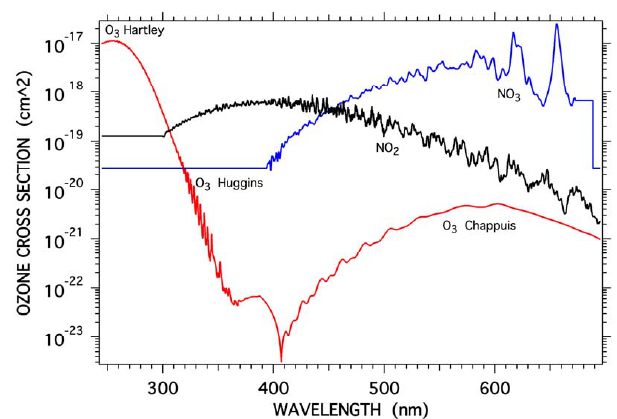
Fig. 2. Cross-sections of ozone (red), NO 2 (black) and NO 3 (blue) at a temperature of 250 K used in the GOMOS spectral inversion. Cross-sections at other temperatures are also used. The Huggins bands are particularly sensitive to temperature.